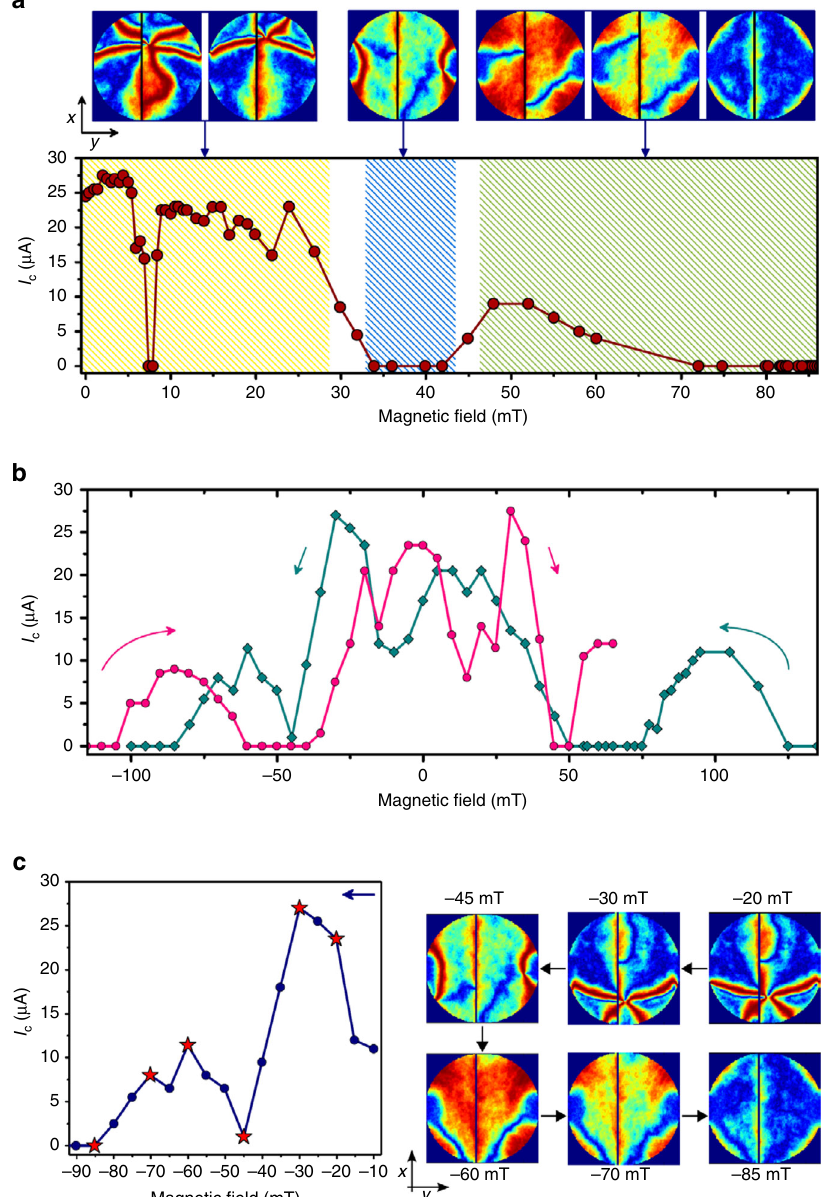
Fig. 5 Critical current variation and MNC simulations with in-plane fi eld. a Measured I c values and the corresponding magnetic non-collinearity (MNC) pro fi les, as the system is magnetized by sweeping the fi eld in + y direction. For small fi elds the vortex core moves along the junction (perpendicular to fi eld direction) to the side of the disk. In this range (shaded yellow), highly non-collinear regions are continuously present and appear to follow the position of the vortex core. The vortex state in Co, which has been effective in suppressing the stray fi elds, is subsequently removed as the fi eld approaches 30 mT. This leads to a negative dipole fi eld from Co which dominates the effective fi eld acting on Ni. As a result, Ni gets magnetized antiparallel to Co (along − y ), hence the suppression of MNC and I c (shaded blue). As the applied fi eld is raised above 45 mT, it begins to compensate for the local stray fi elds from the Co layer, ultimately reversing the Ni magnetization along + y . The change in the magnetic orientation associated with this reversal leads to a distinct (re-)emergence of MNC that gradually fades away above 60 mT — as Ni magnetization aligns with Co (shaded green). b I c measured while reversing the fi eld in both directions along y . A clear hysteresis is observed, with individual features are mirrored with respect to fi eld sweep direction. This complex pattern is a result of a changing MNC as the multilayer reverses its magnetization. c Positive to negative branch of experimentally measured I c ( B y ) shown together with simulated MNC pro fi les. Each MNC snapshot is obtained at the speci fi ed fi eld, and corresponds to a measurement labeled by the star symbol. Taking steps of 5 mT, simulation shows the vortex enters at − 20 mT, moves along − x , and exits the system at − 45 mT. The MNC is once again is enhanced at − 60 mT, and gradually fades away as the fi eld magnetizes all layers along −